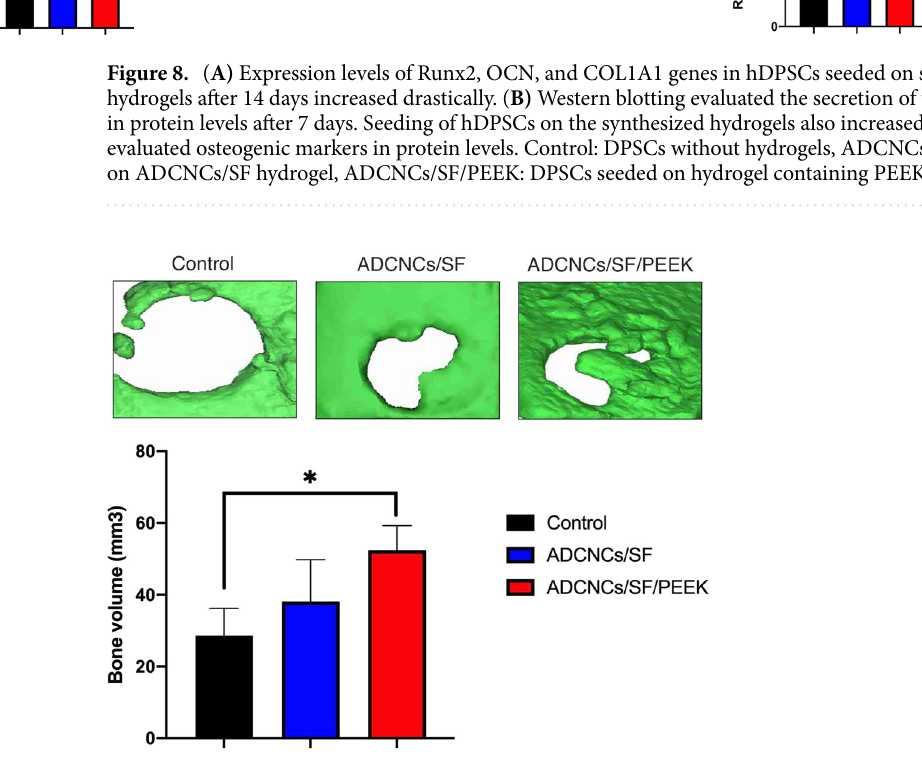
Figure 9. ADCNCs/SF/PEEK injectable hydrogels drastically increased bone formation after 8 weeks, as proved by CBCT. The almost full closure occurred in ADCNCs/SF/PEEK group, while ADCNCs/SF group caused less bone volume in the defect area. Bone volume (mm 3 ) was measured in defects sites of all samples. The significant difference was between ADCNCs/SF/PEEK groups with control. Control: critical-sized bone defects without any treatment, ADCNCs/SF: critical-sized bone defects filled with hydrogel without PEEK, ADCNCs/SF/PEEK: critical-sized bone defects filled with the hydrogel containing PEEK (* P <